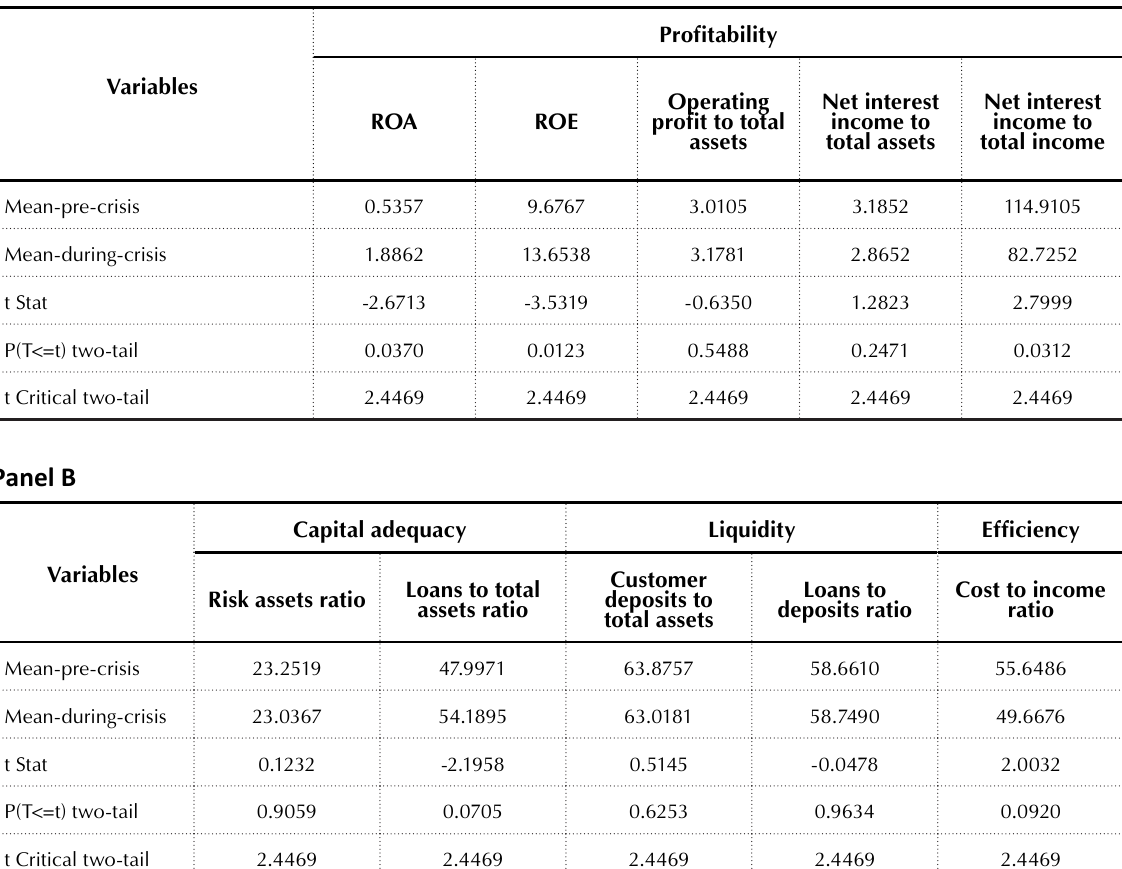
Table 6. Result of t-test (all banks)